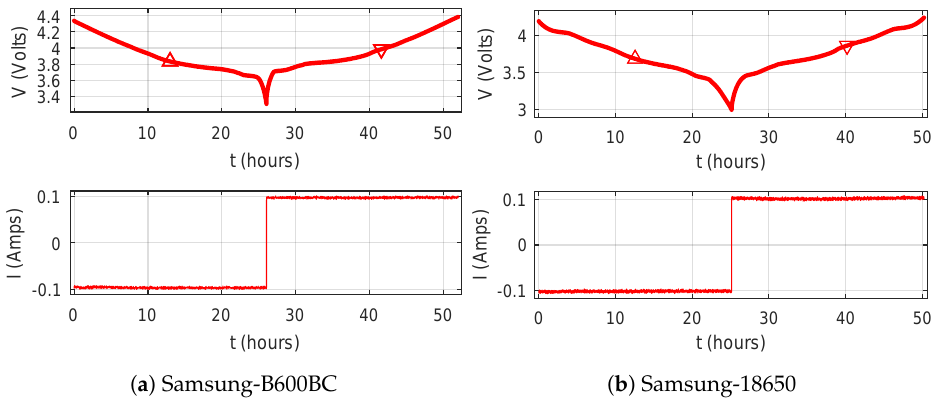
Figure 3. Response of batteries for the charging–discharging